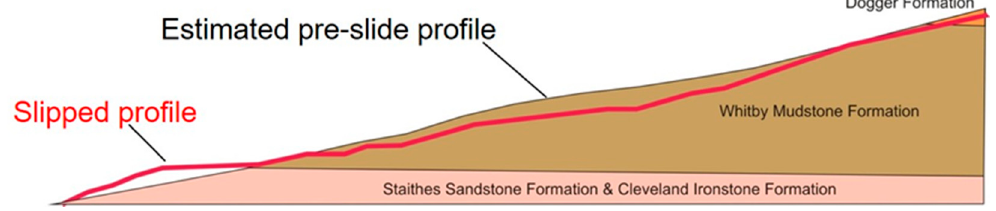
Figure 14. Solid Geology model of the Hollin Hill landslide (not to scale).